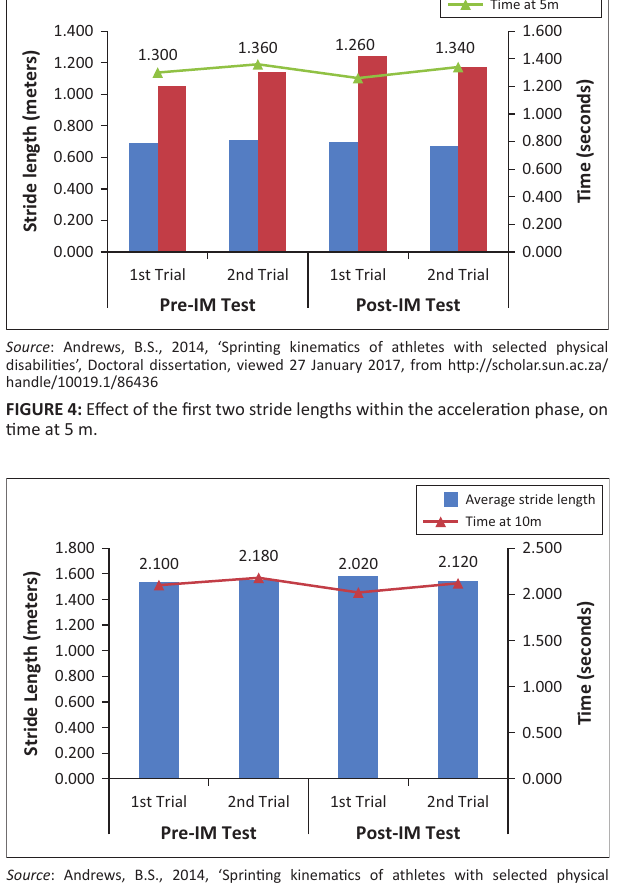
FIGURE 5: Effect of the average stride length within the acceleration phase, on time at 10